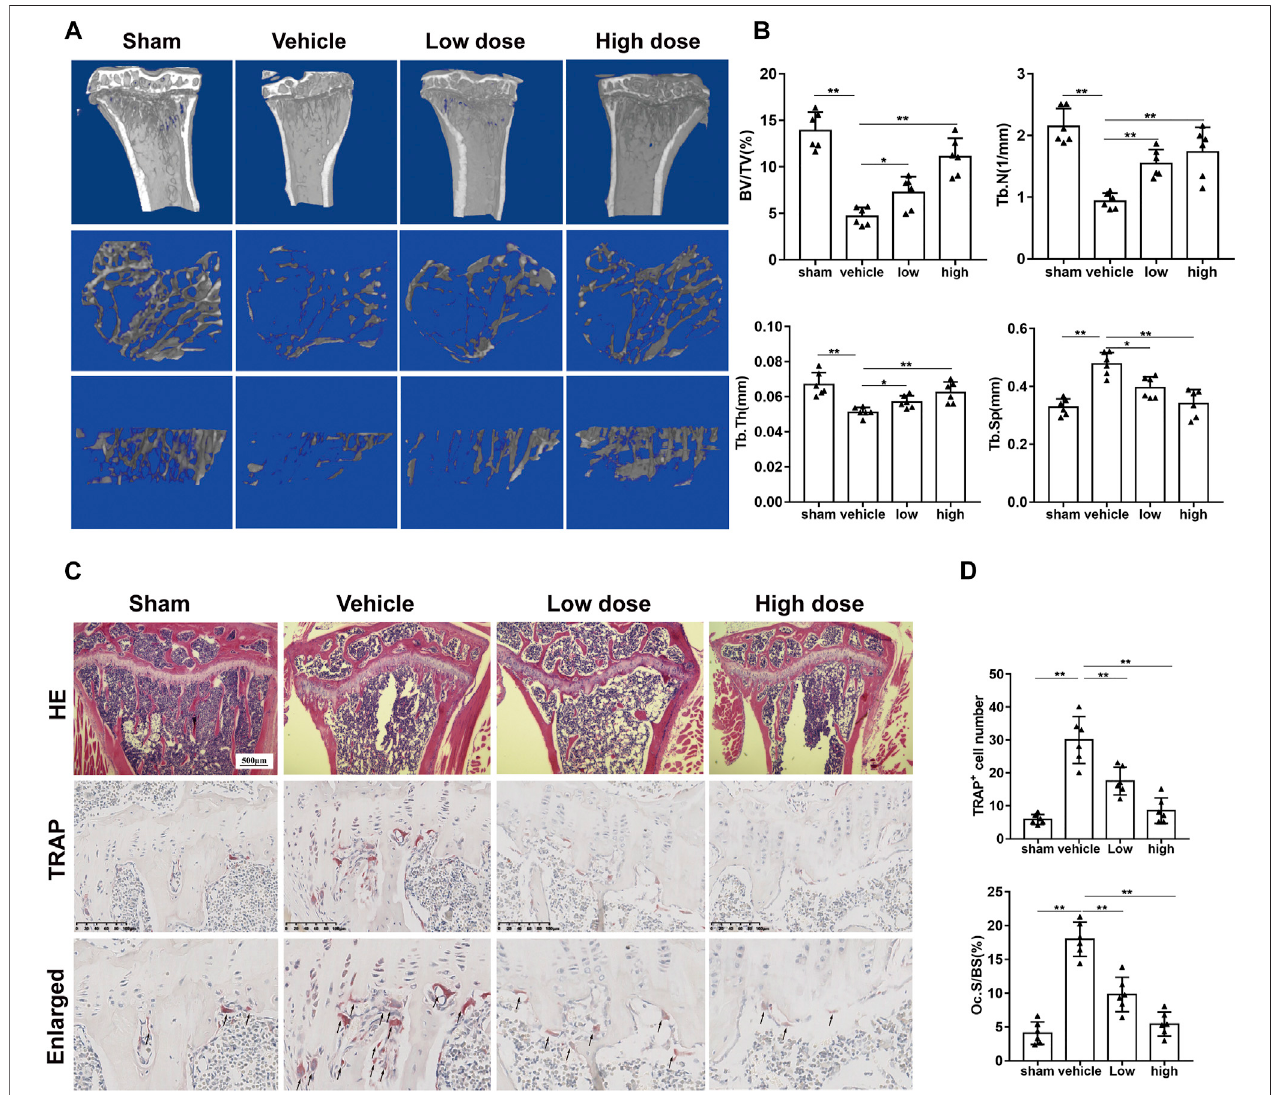
FIGURE6 | Azilsartan administration prevents OVX-induced bone loss in vivo . (A) Micro-CT reconstruction ofproximal tibial bone ofmice from each group: sham- treated (sham), OVX with normal saline gavage (vehicle), OVX with 1 mg/kg Azilsartan gavage (low dose), OVX+ 3 mg/kg Azilsartan gavage (high dose). (B) The trabecular thickness (Tb. Th), bone volume/tissue volume (BV/TV), trabecular number (Tb. N), and trabecular separation (Tb. Sp) were measured to evaluate the bone tissuemicrostructure( n (cid:2) 6pergroup). (C) RepresentativeH&E(upperpanel)andTRAPstaining(lowerpanel)sectionsfromeachgroup. (D) Quantitativeanalysisof the osteoclasts on the surface of trabecular bone and the Oc.S/BS (%) using ImageJ ( n (cid:2) 6 per group). All data were shown as mean ± SD. (* p < 0.05, ** p < 0.01, *** p < 0.005, compared with the vehicle group).